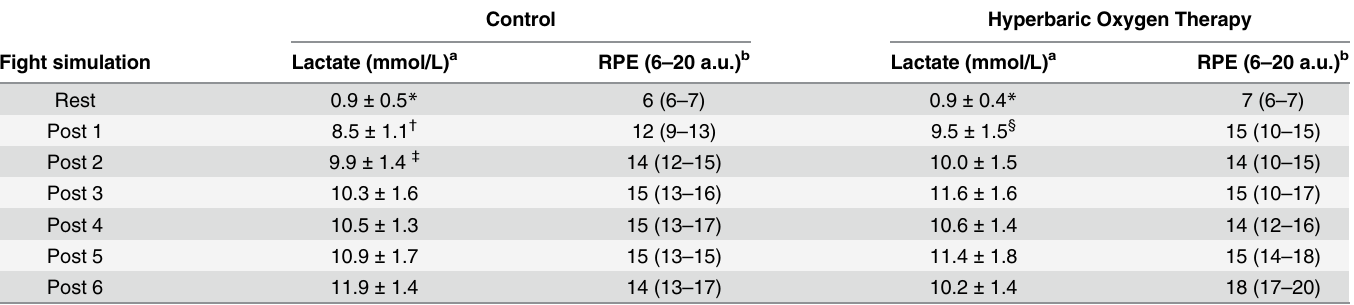
Table 1. Lactate concentration and rating of perceived exertion (RPE) in Brazilian jiu-jitsu athletes at rest and following the combat simulations for the control and hyperbaric oxygen therapy conditions (n = 11).